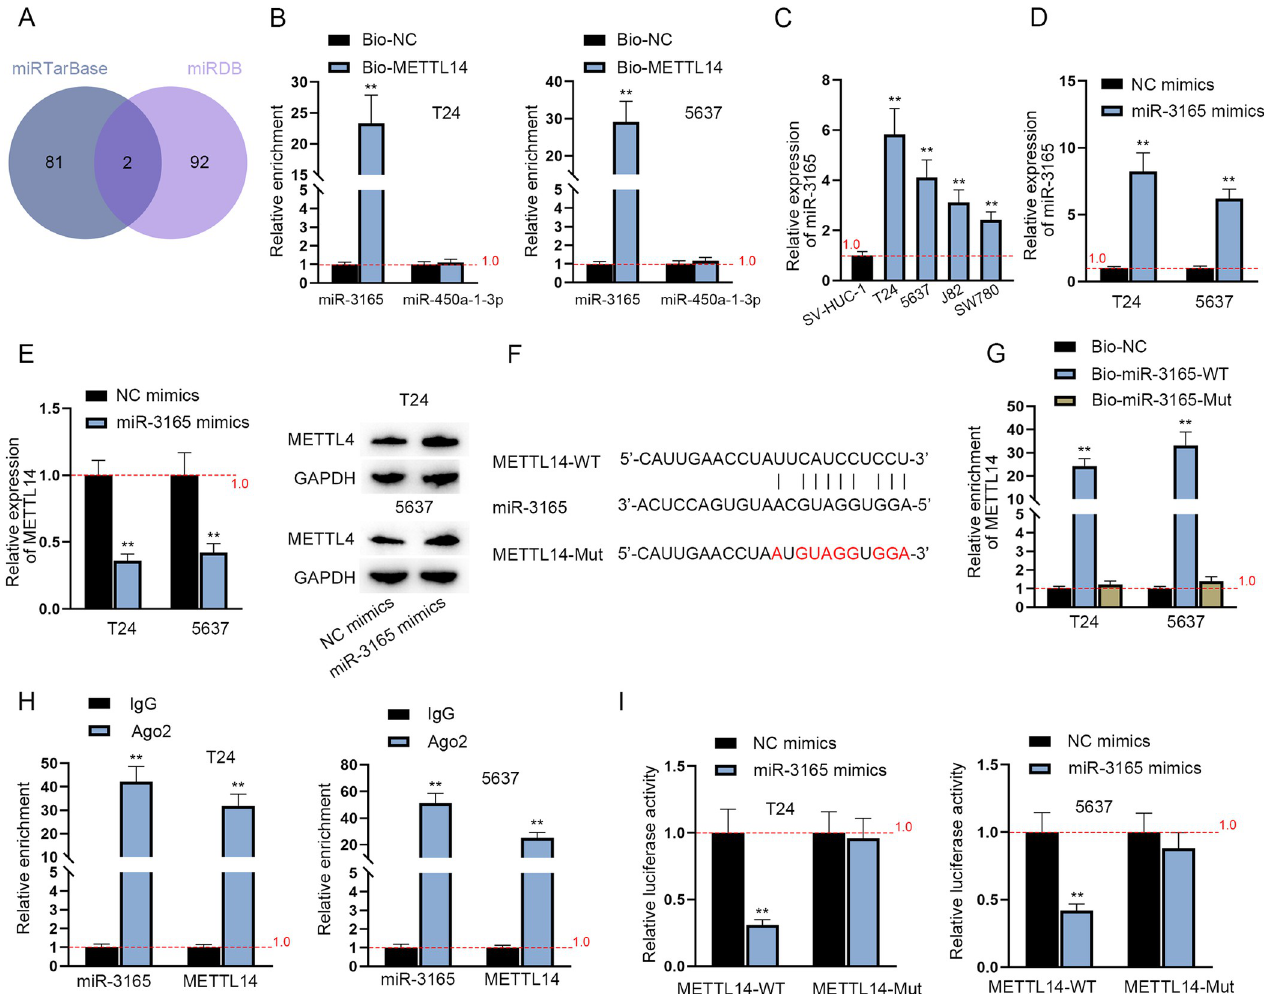
Fig 6. MiR-3165 regulates METTL14 as the upstream gene. A. 2 miRNAs were predicted to bind to METTL14 via miRTarBase (http://mirtarbase.cuhk.edu. cn/php/index.php) and miRDB (http://mirdb.org/). B. RIP assays were conducted to verify the interaction between METTL14 and miR-3165/miR-450a-1-3p in BCa cells. (n = 3) Each bar represents mean; error bars represent SD. P values were determined by two-way ANOVA followed by Tukey’s test. C. RT-qPCR was used to assess the relative expression of miR-3165 in SV-HUC-1 cell line and BCa cell lines. (n = 3) Each bar represents mean; error bars represent SD. P values were determined by one-way ANOVA followed by Dunnett’s test. D. RT-qPCR was used to determine the overexpression efficiency of miR-3165 mimics. (n = 3) Each bar represents mean; error bars represent SD. P values were determined by Student’s t test. E. The relative expression of METTL14 in miR-3165 mimics-transfected BCa cells was assessed through RT-qPCR (left panel). (n = 3) Each bar represents mean; error bars represent SD. P values were determined by Student’s t test. Western blot analysis of METTL14 protein level in miR-3165 mimics-transfected cells (right panels). F. The potential binding site between METTL14 and miR-3165 was predicted through miRBase database. G. RNA pulldown assay was performed to determine the combination between METTL14 and miR-3165 in BCa cells. (n = 3) Each bar represents mean; error bars represent SD. P values were determined by one-way ANOVA followed by Dunnett’s test. H. RIP assay was applied to verify the interaction between METTL14 and miR-3165 in BCa cells. (n = 3) Each bar represents mean; error bars represent SD. P values were determined by Student’s t test. I. Luciferase reporter assays were conducted to validate the combination between METTL14 and miR-3165 in BCa cells. (n = 3) Each bar represents mean; error bars represent SD. P values were determined by two-way ANOVA followed by Tukey’s test. �� P < 0.01. See also S4